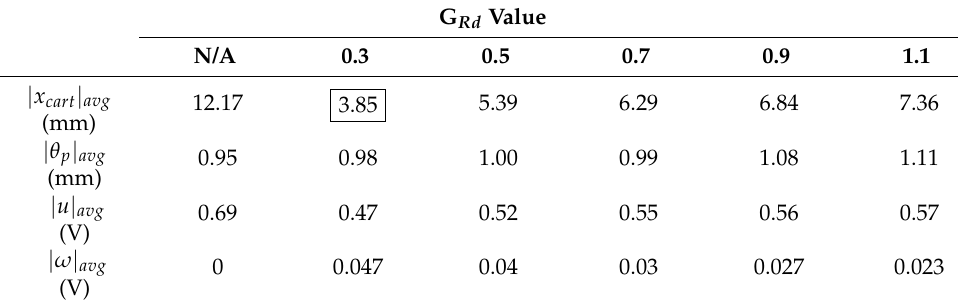
Table 4. The mean absolute values of outer-loop LQR d tuning